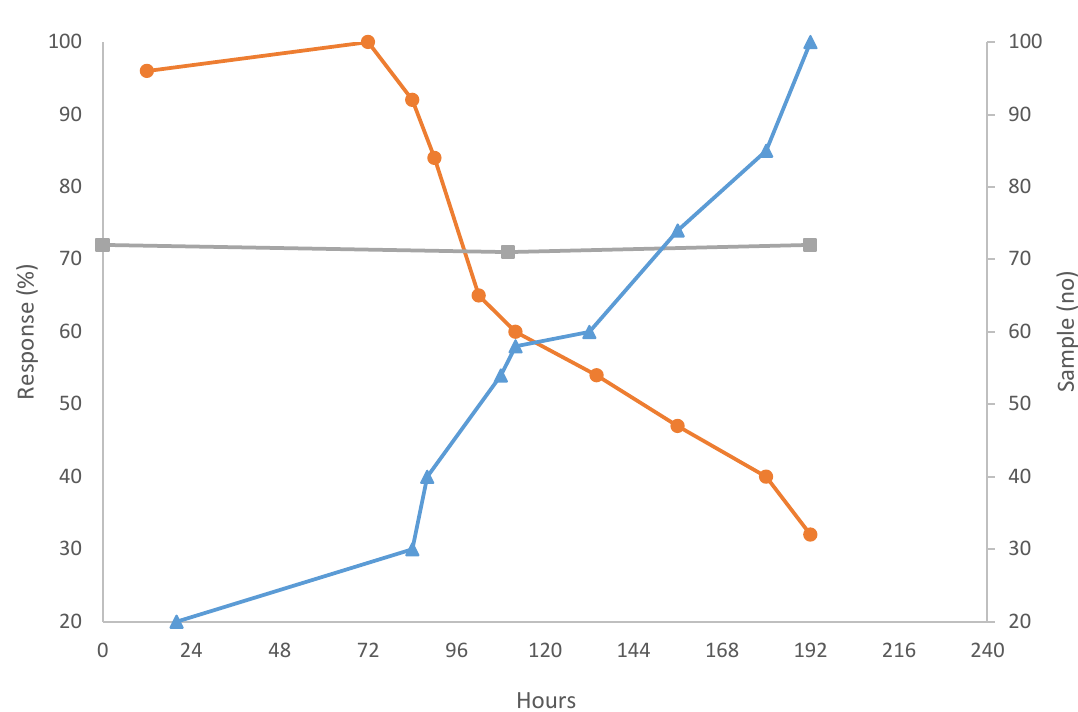
Figure 1. Response stability of antibody-Sepharose CL 4-B preparation. Orange line (circle) shows the peak height obtained when assaying a 100% sample. Blue line (triangle) shows number of assay cycles run. Grey line (square) shows the peak height in percent of a preceding pure aggregate pulse obtained for reference samples containing 40 µ g HSA/mL sample (Modified from [3]).